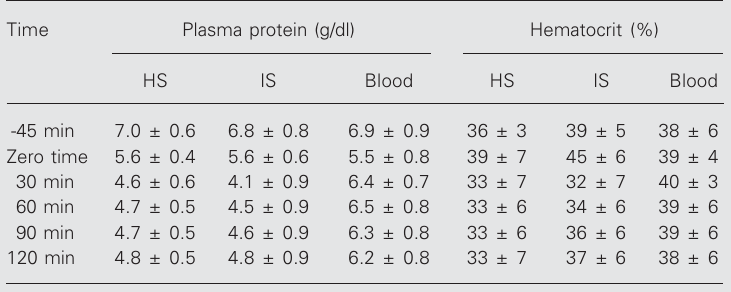
Table 1. Plasma protein and hematocrit of bled animals submitted to various types of